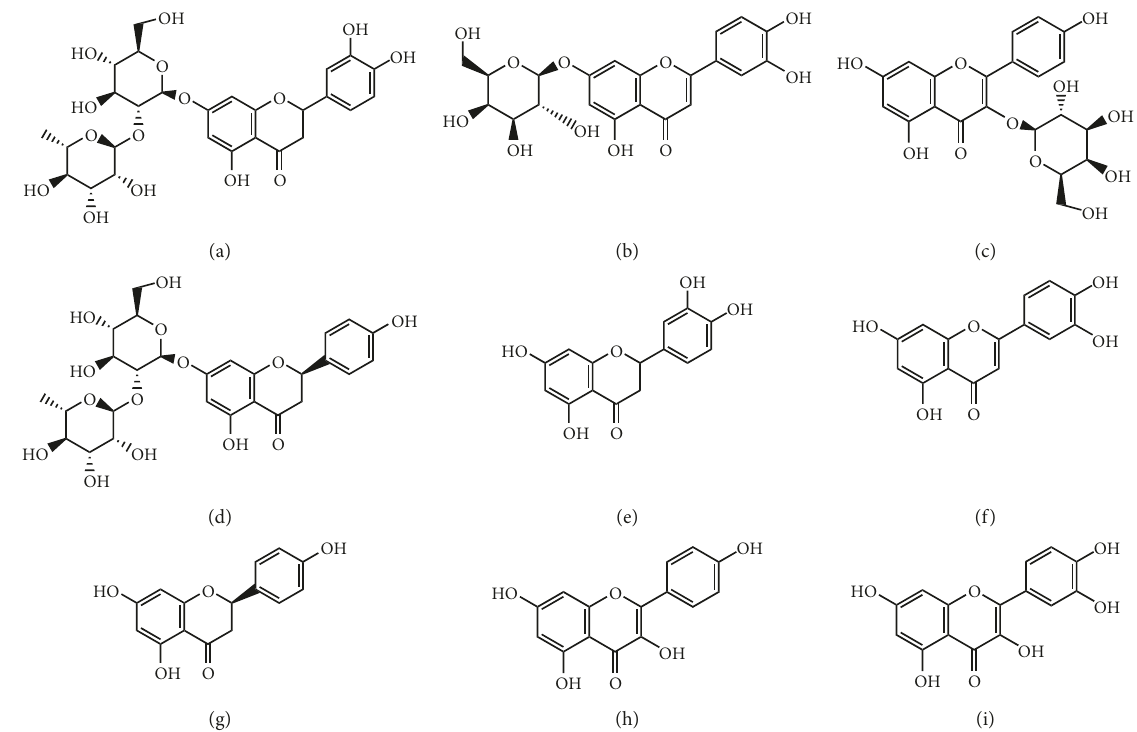
Figure 1: Chemical structures of eight analytes and IS. (a) Neoeriocitrin. (b) Luteolin-7- O - β - D -glucoside. (c) Astragalin. (d) Naringin. (e) Eriodictyol. (f) Luteolin. (g) Naringenin. (h) Kaempferol. (i) Quercetin. Table 1: Precursor ion and product ion transition and parameters of the analytes used in this study.